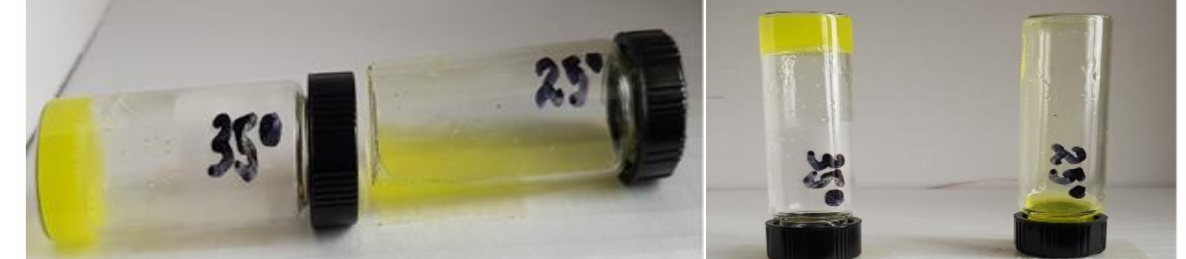
Figure 3. Curc-GS niosomal thermosensitive in situ gel at 35 ◦ C and at ambient